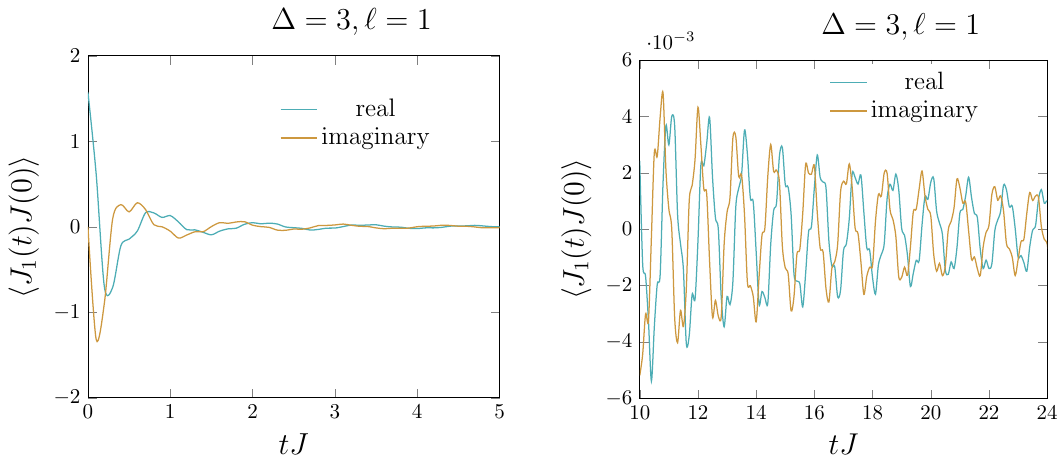
( t ) J (cid:11) for ∆ = 3, L Figure 2: 〈 J 1 (right).